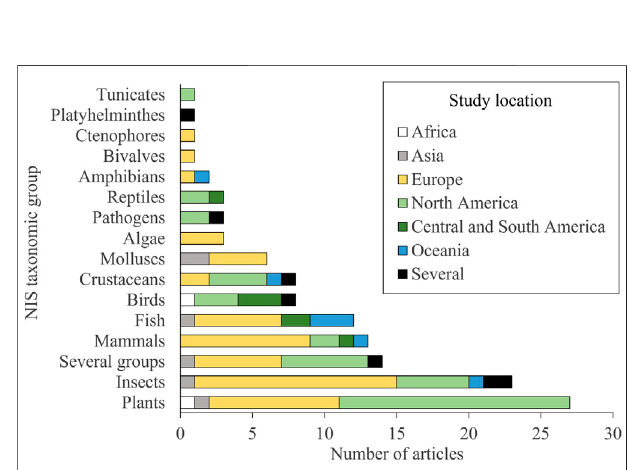
FIGURE 3 | Number of articles published on citizen science and non- indigenousspecies(NIS)accordingto16taxonomiccategories.Thecontinent where the studies were made is also included. A total of 126 studies reported informationonthisissue.Datawereretrievedfromabibliographicsurvey made in July 2019 with SCOPUS using a combination of keywords: “ invasive species ” and “ citizen science ” , “ non-indigenous species ” and “ citizen science ” , and “ non-native species ” and “ citizen science ” .